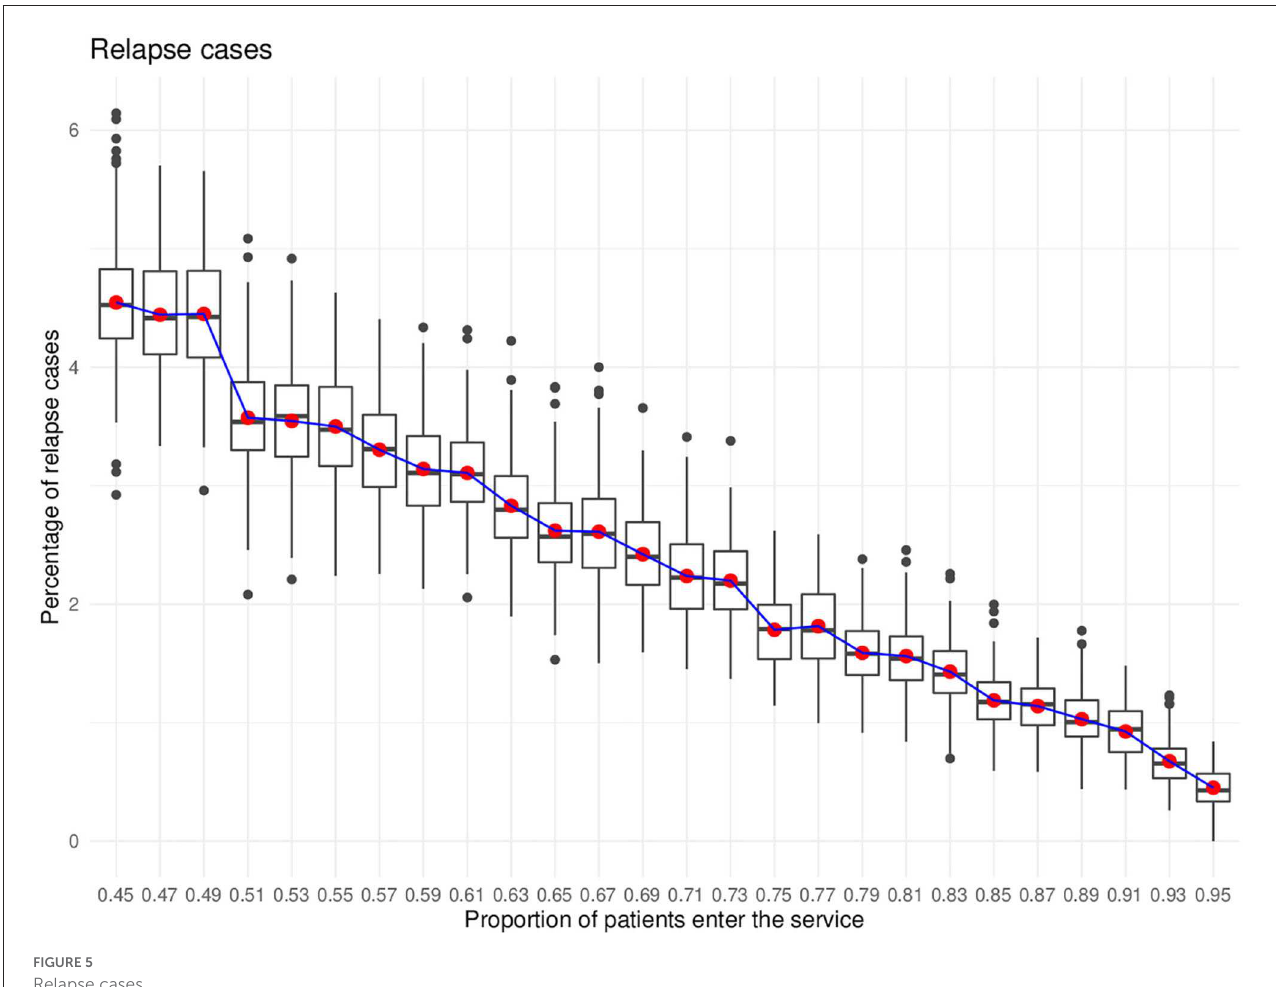
FIGURE5 Relapse cases.